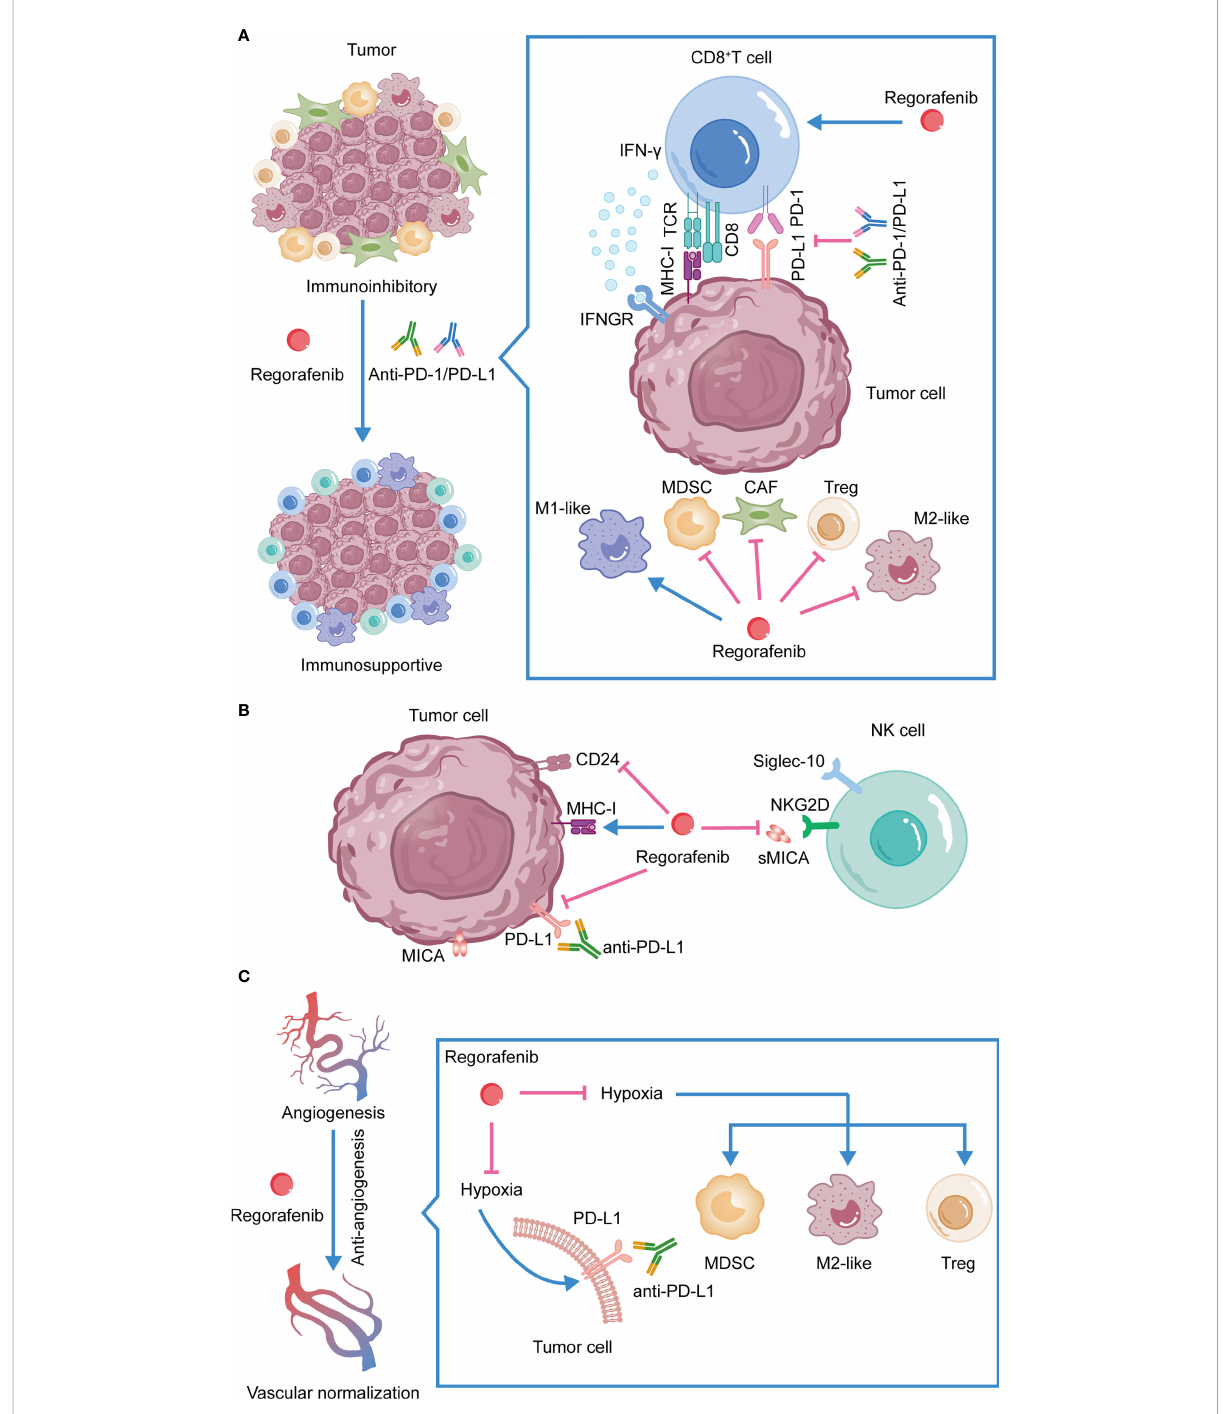
FIGURE 2 The synergistic antitumor ef fi cacies and mechanisms of anti-PD-1/PD-L1 in combination with regorafenib. (A) Combination therapy reshapes the TME. (B) Regorafenib activates NK cells, inhibits the expression of PD-L1 on tumor cells and promotes the expression of MHC-I. (C) Regorafenib promotes vessel normalization, enhances drug delivery, alleviates hypoxia-induced PD-L1, reduces hypoxia-induced in fi ltration of suppressive immune cells, and increases the ef fi cacy of anti-PD-1/PD-L1